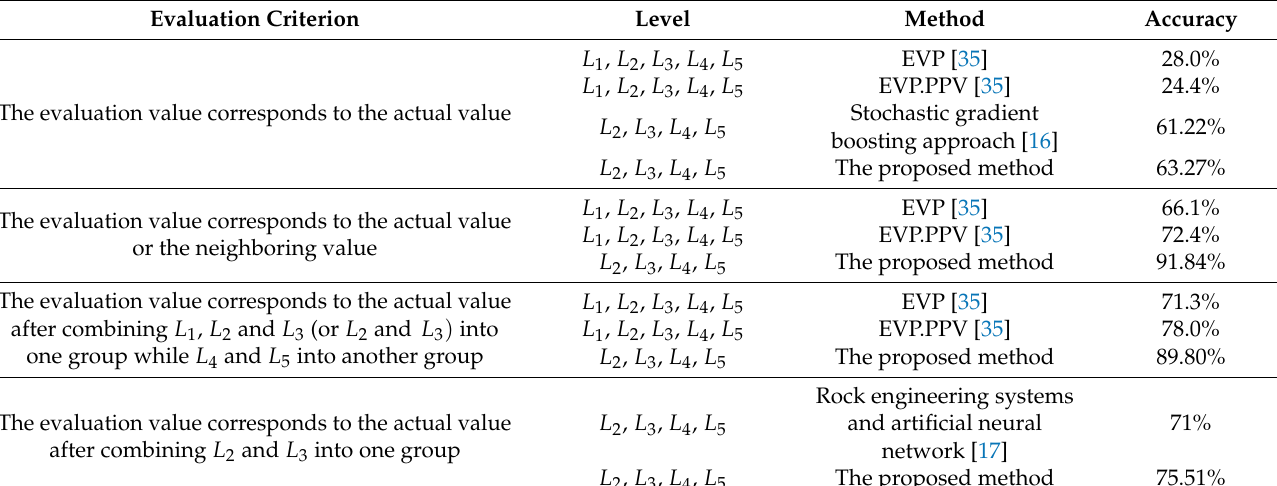
Table 2. Comparison of evaluation results in different